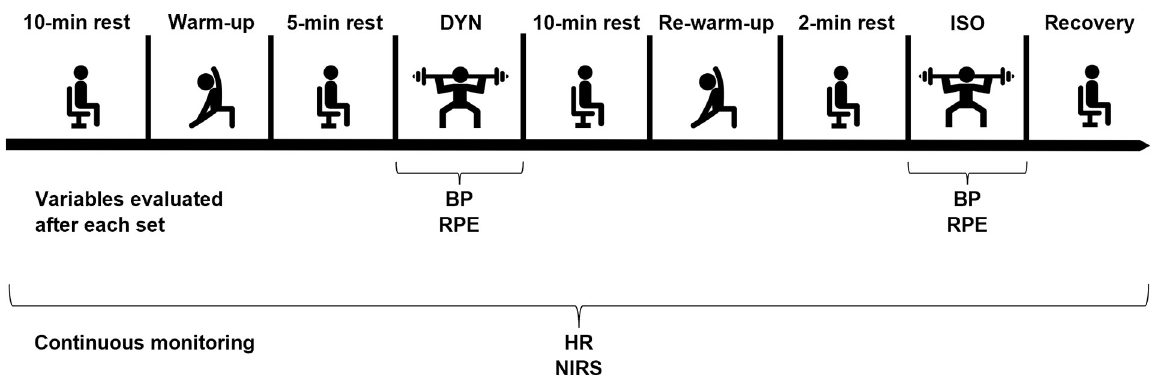
Fig 1. Schematic representation of the experimental procedures. DYN, dynamic contractions protocol; ISO, isometric contractions protocol; BP, blood pressure; RPE, rate of perceived exertion; HR, heart rate; NIRS, near-infrared spectroscopy.